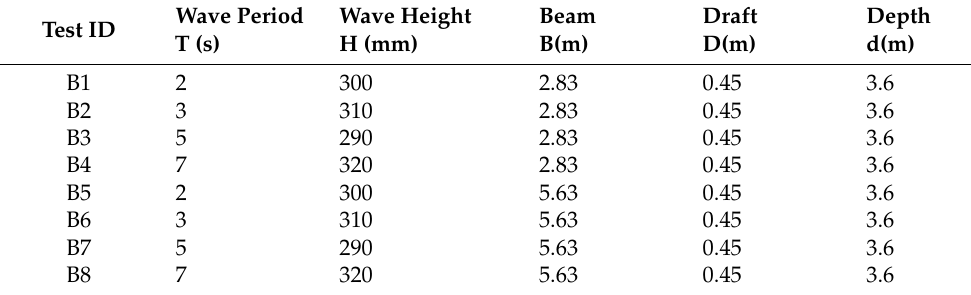
Table 3. Monochromatic Wave Testing Parameters (Prototype Scale).